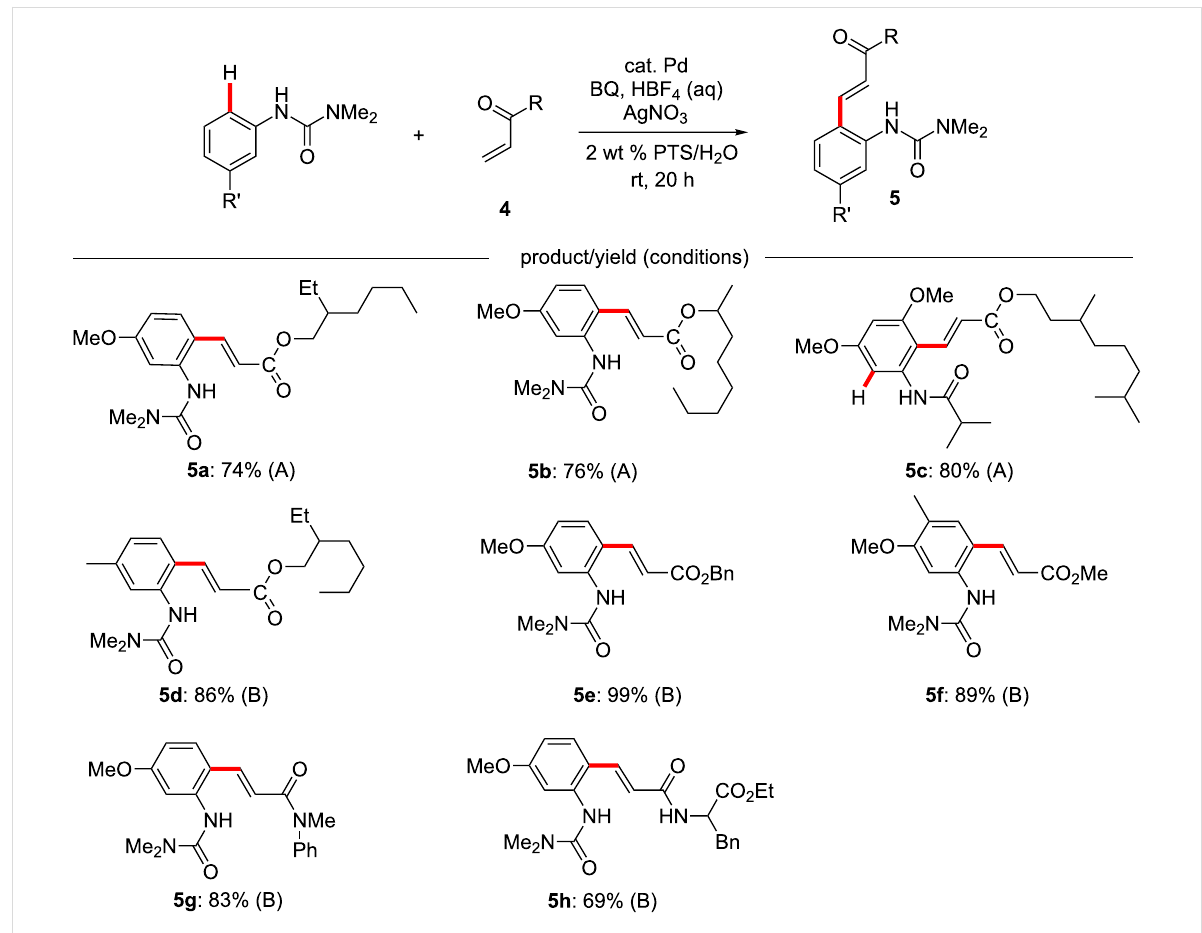
Figure 4: Fujiwara–Moritani coupling rreactions in water. Conditions A: 10 mol % [Pd(MeCN) 4 ](BF 4 ) 2 , 1 equiv BQ, 2 equiv AgNO 3 , 2 wt % PTS/water, rt, 20 h. Conditions B: 10 mol % Pd(OAc) 2 , 1 equiv BQ, 2 equiv AgOAc, 5 equiv HBF 4 aq, 2 wt % Brij 35/water, rt, 20 h.